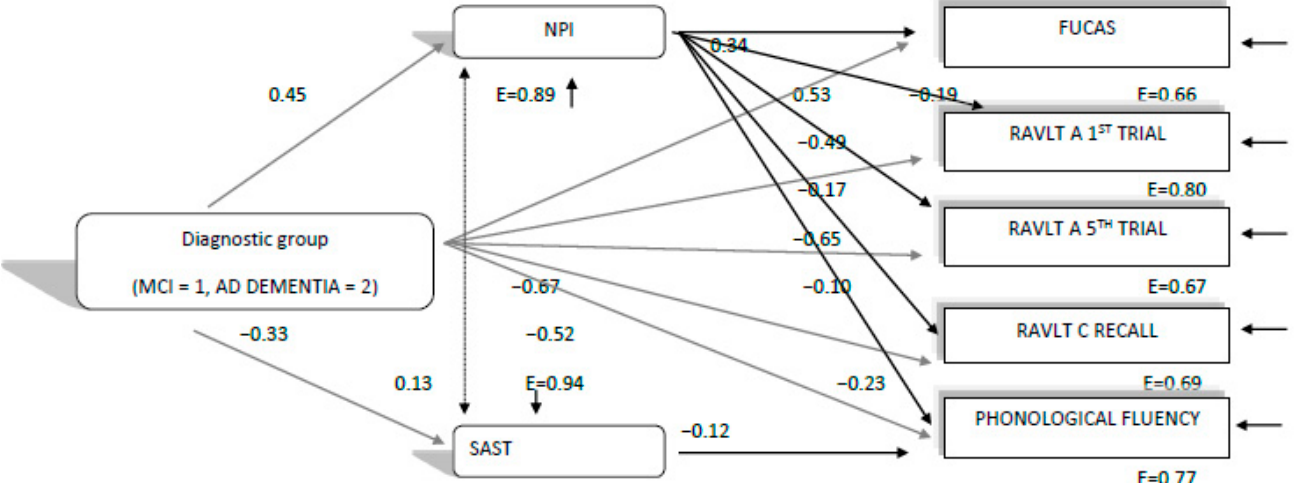
Figure 1. Direct and indirect relationships of diagnostic group (MCI, ADD) and negative affect (NPI, SAST) variables with everyday functioning and cognitive variables, which were found to decline faster between the 2019 and 2020 measurements than between 2018 and 2019, as measured in the 2020 neuropsychological assessment during COVID-19-related lockdowns. All relationships are significant at the p < 0.05 level. E = measurement error. All everyday functioning and cognitive variables were found to correlate significantly ( p < 0.05) between each other.